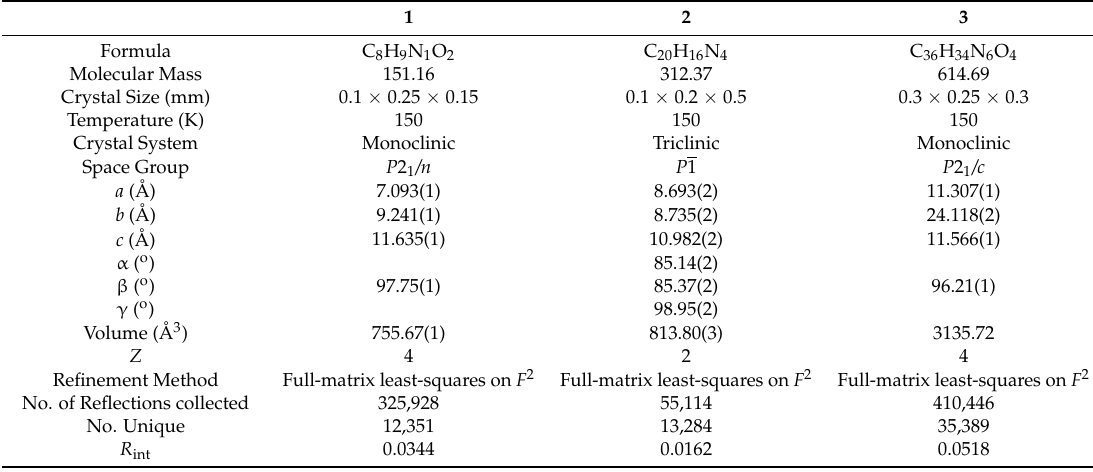
Table 1. Selected crystallographic information for ( 1 ), ( 2 ) and ( 3 ). IAM, independent atom model.